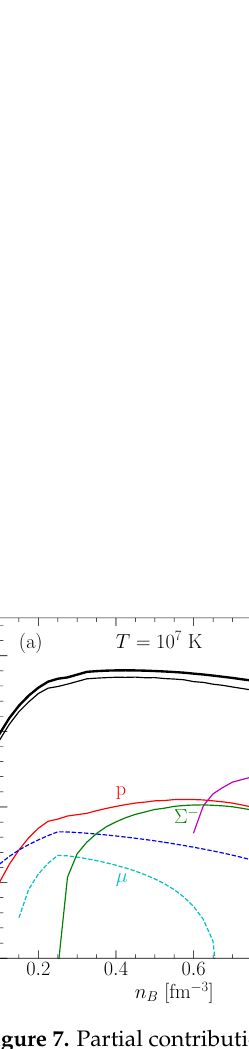
Figure 7. Partial contributions to the thermal conductivity coefficient (variational solution) for the β -stable matter in NS cores. Results for the NSC97e model are shown. Particle species labels are shown near the corresponding curves. The total thermal conductivity including corrections to the variational solution is shown with the thick solid line. Results for three values of the temperature are shown: T = 10 7 K ( a ), T = 10 8 K ( b ) and T = 10 9 K ( c ).